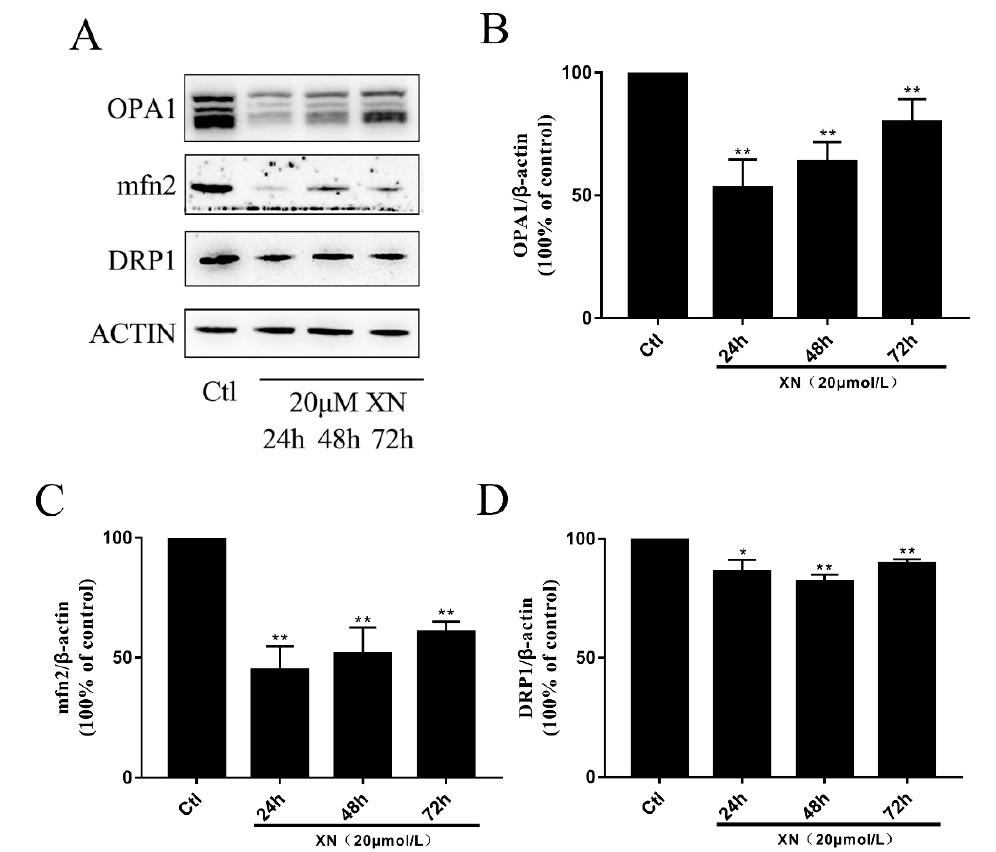
Figure 8. Effect of XN (20 uM) on mitochondrial fusion and fission. The C6 cells were exposed to XN for 24 h, 48 h, and 72 h. ( A )The OPA1, mfn2, and DRP1 expression levels were analyzed by Western blot, and ACTIN was used as a loading control. ( B – D ) Quantitative analysis of the expression levels of OPA1, mfn2 and DRP1. All data presented are the mean ± SEM from three independent experiments. * p < 0.05, ** p < 0.01 vs. control groups.